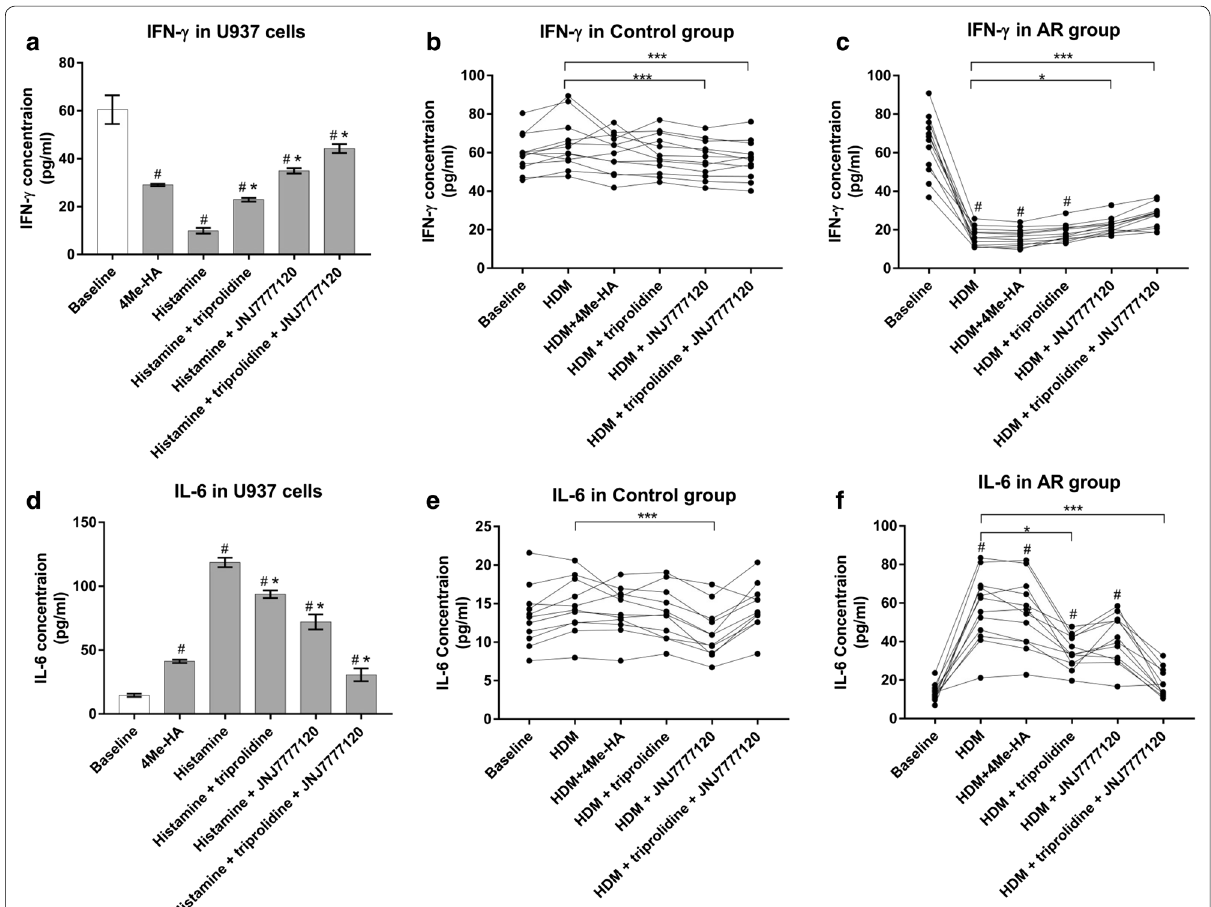
Fig. 2 Blockage effects of H1R, H4R antagonists in U937 cells and human native monocytes with regard to IFN-γ and IL-6 secretion. IFN-γ and IL-6 levels were compared in U937 cells treated with H1R or H4R antagonist alone or combined H1R and H4R antagonists after histamine stimulation ( a , d ). IFN-γ and IL-6 levels were compared in native monocytes from healthy subjects ( b , e ) or allergic rhinitis patients ( c , f ) by treating with H1R or H4R antagonist alone or combined H1R and H4R antagonists after house dust mite (HDM) stimulation. Data are shown as the mean versus baseline. * p < 0.05, ** p < 0.01, *** p < 0.001 versus histamine-stimulated or HDM-stimulated